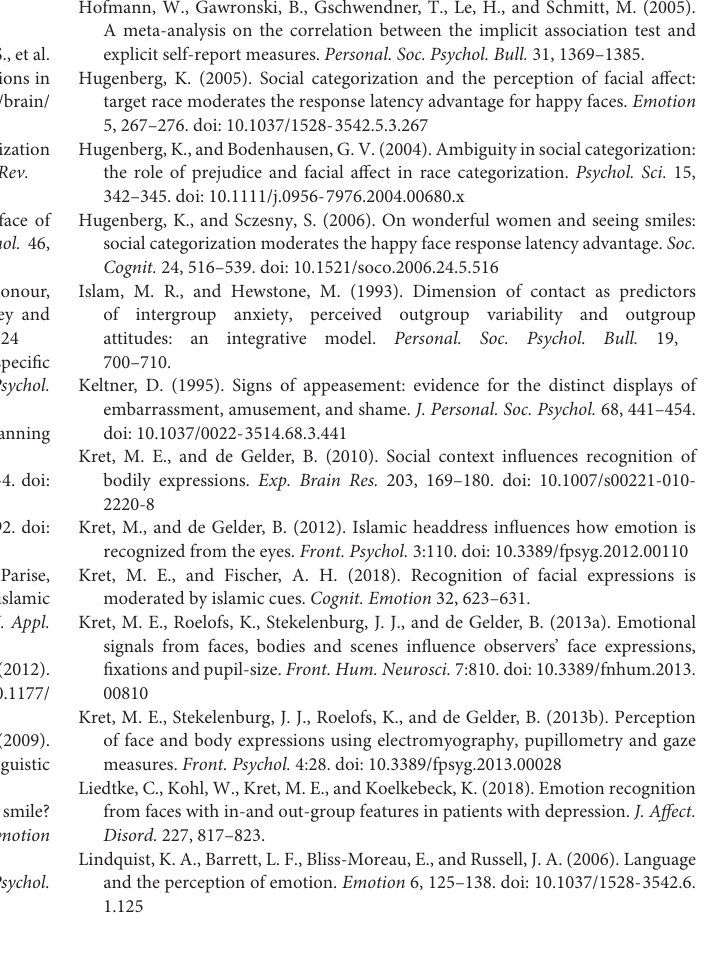
Supplementary Table 1 | All ratings (congruent and